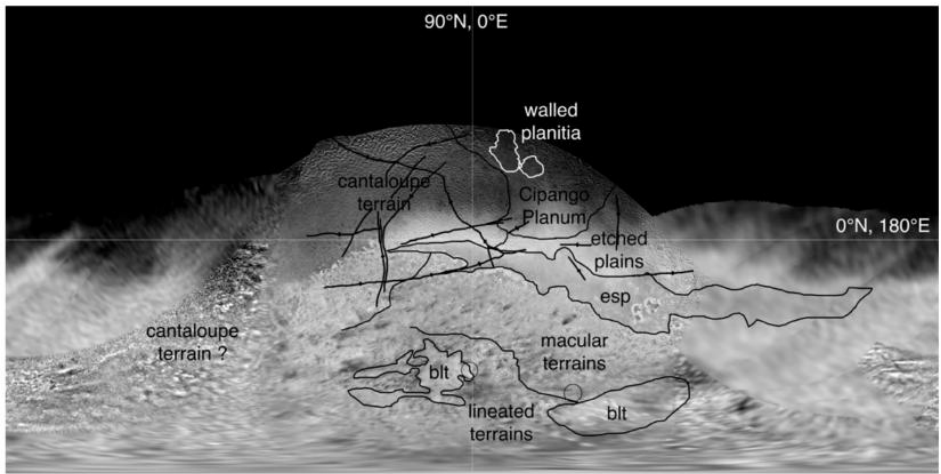
Figure 9. Global mosaic of Triton annotated to highlight major features discussed in the text. Narrow curvilinear markings are approximate terrain boundaries, heavy lines are linear features such as ridges Map by P. Schenk modified from [30] and [8]. Map boundaries are notional in areas where boundaries are